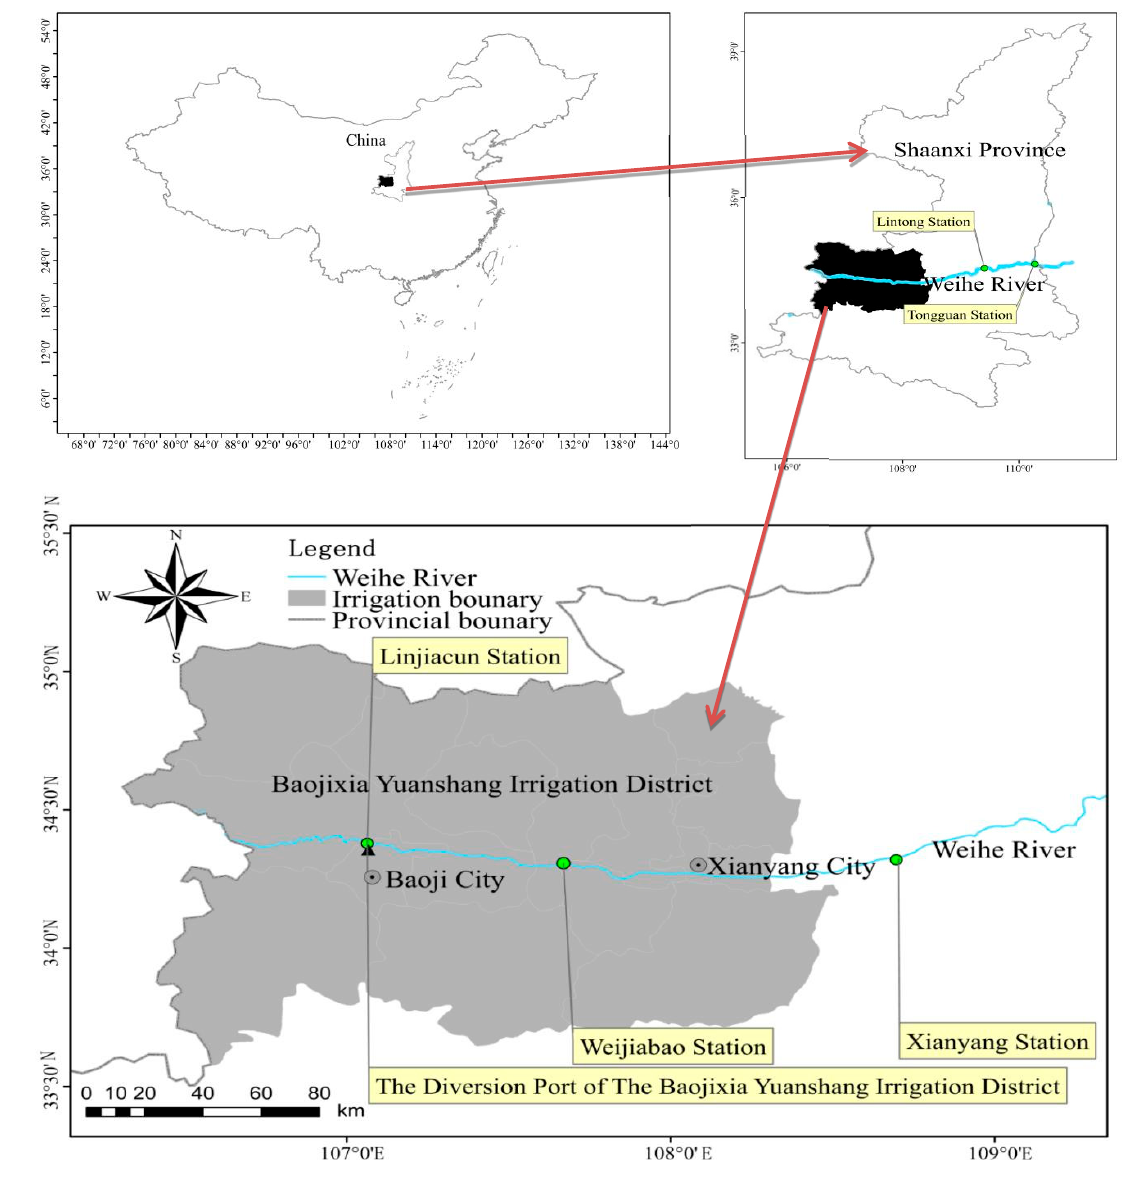
Figure 1. Location of the Weihe River and Baojixia Yuanshang Irrigation District [37].